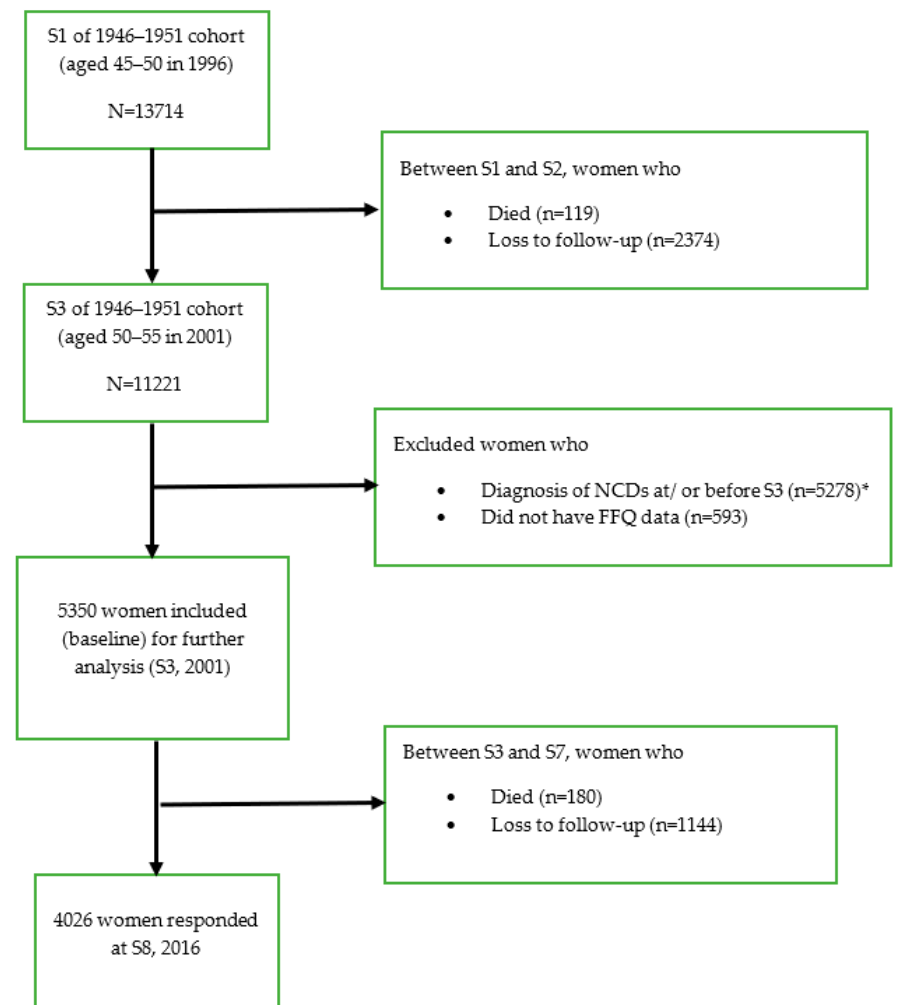
Figure 2. Flow diagram showing the selection of participants from the Australian Longitudinal Study on Women’s Health (ALSWH), born between 1946 and 1951. * NCDs at or before S3 were diabetes mellitus, coronary heart disease, hypertension, asthma, and cancer (excluding skin cancer).